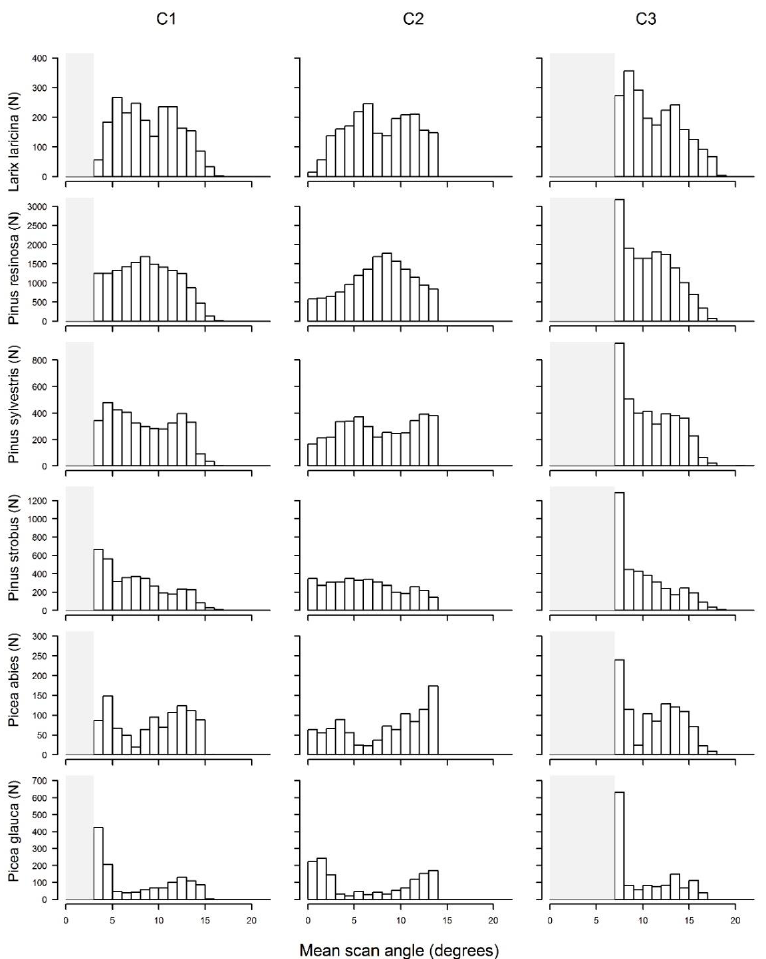
Figure 4. Distributions of mean scan angle of the tree views by channel (C1, C2 and C3) and species. The grey-shaded areas represent mean scan angles that are not achievable in the respective channels due to the Titan system’s configuration.